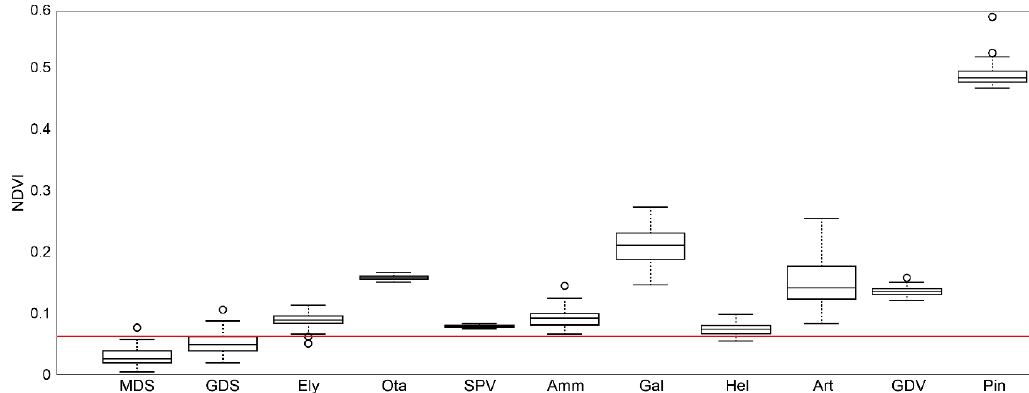
Figure 7. Boxplot of normalized difference vegetation index (NDVI) computed with red edge spectral bands. Within the boxes, bold lines represent median and lower and upper hinges represent first and third quartiles. At the maximum, bars correspond to 1.5 times the interquartile distance and solid circles correspond to observations outside the bars. The red line corresponds to the NDVI threshold of 0.061.